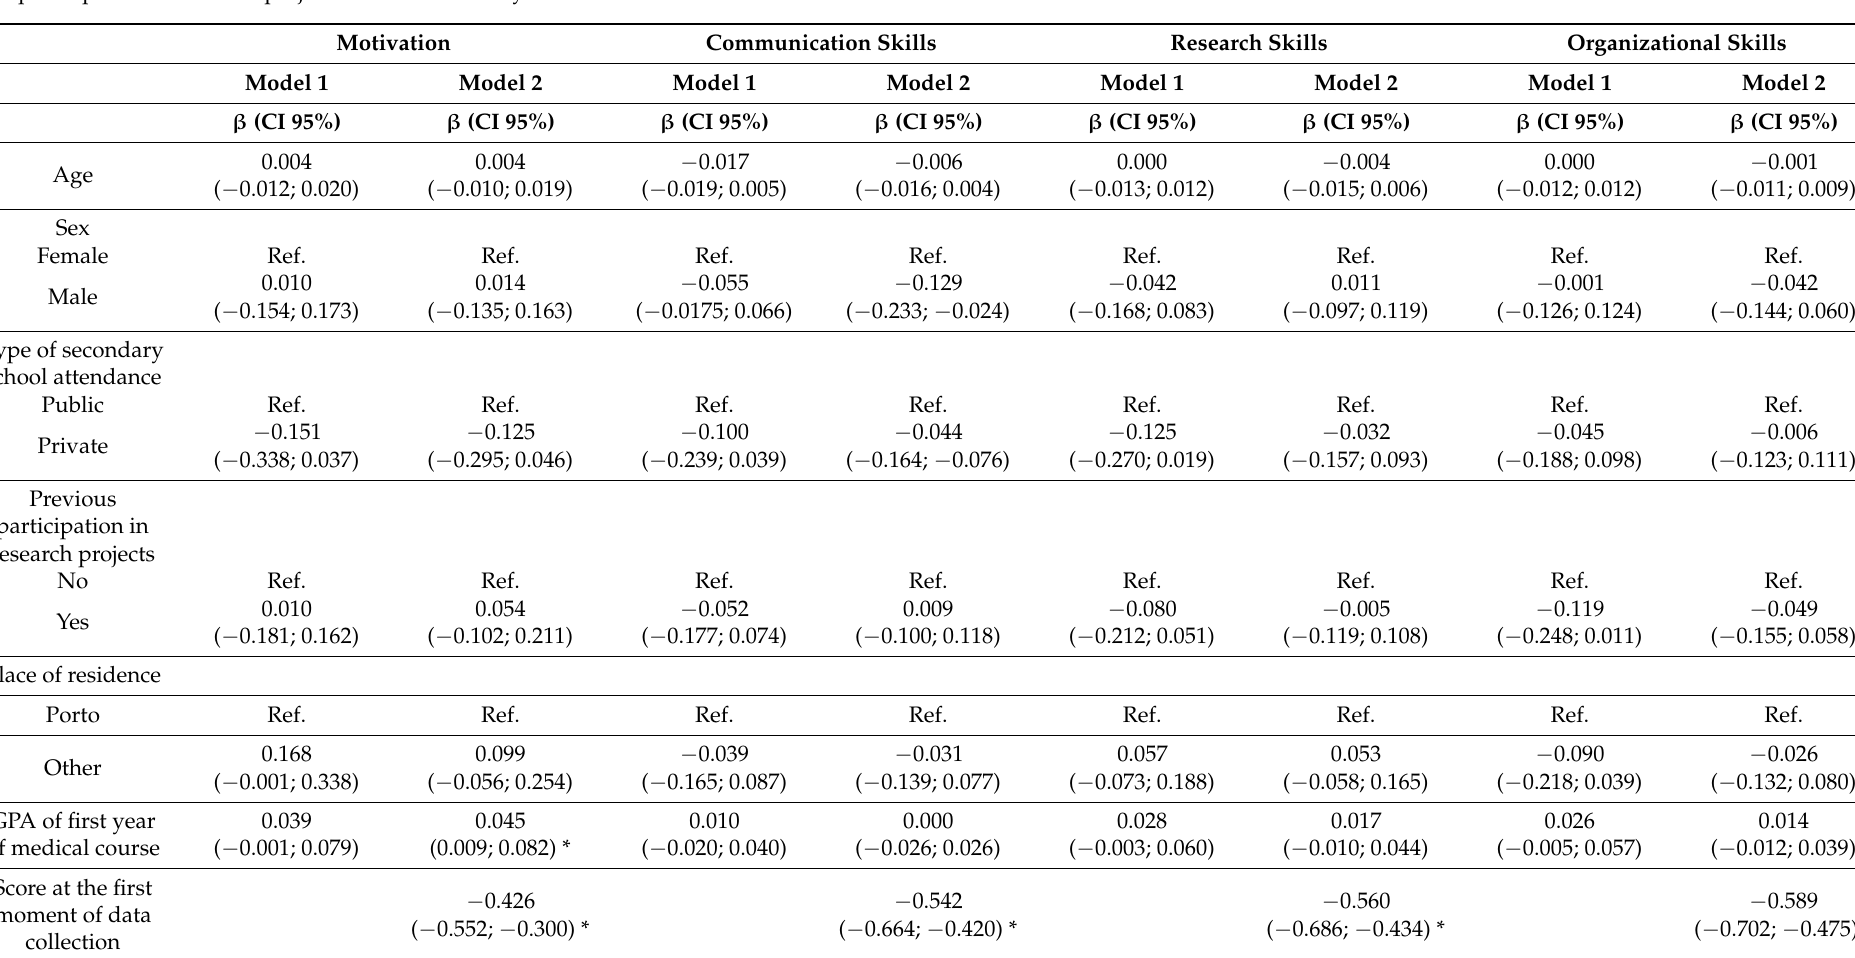
Table 4. Regression models of association between Motivation, Communication Skills, Research Skills, Organizational Skills, Age, Sex, Type of secondary school attendance, Previous participation in research projects and GPA of first year of medical